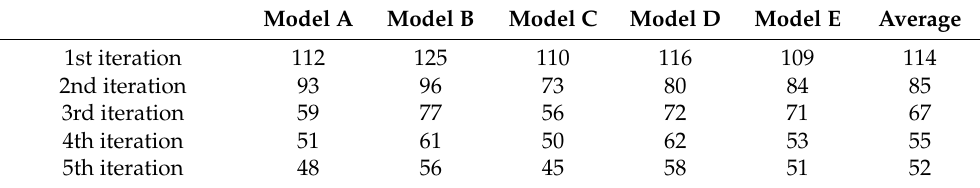
Table 4. The number of species as important features in the five optimal prediction models selected in each iteration of the Moscow and Shenzhen cohorts. The iterations became stabilized in the third